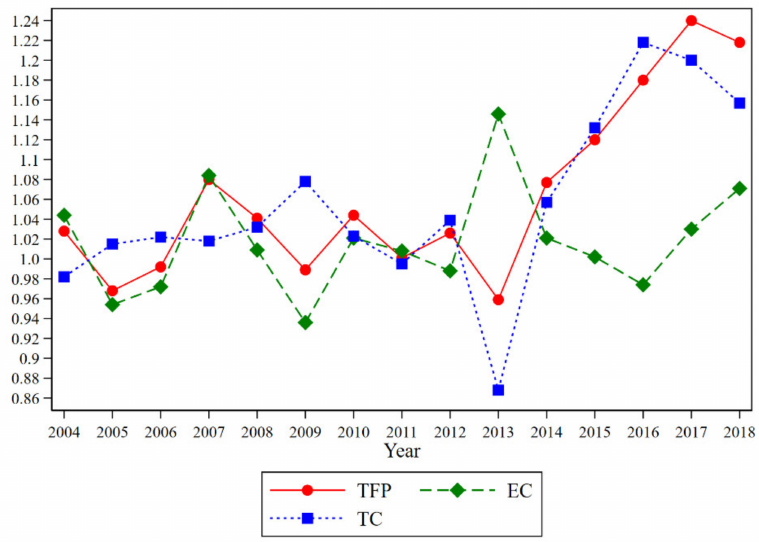
Figure 2. China’s green total factor productivity and its decomposition term growth rate.